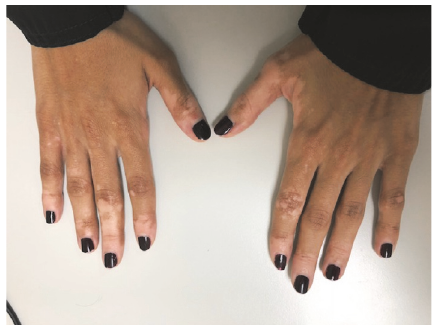
Figure 1: Vitiligo lesions in the